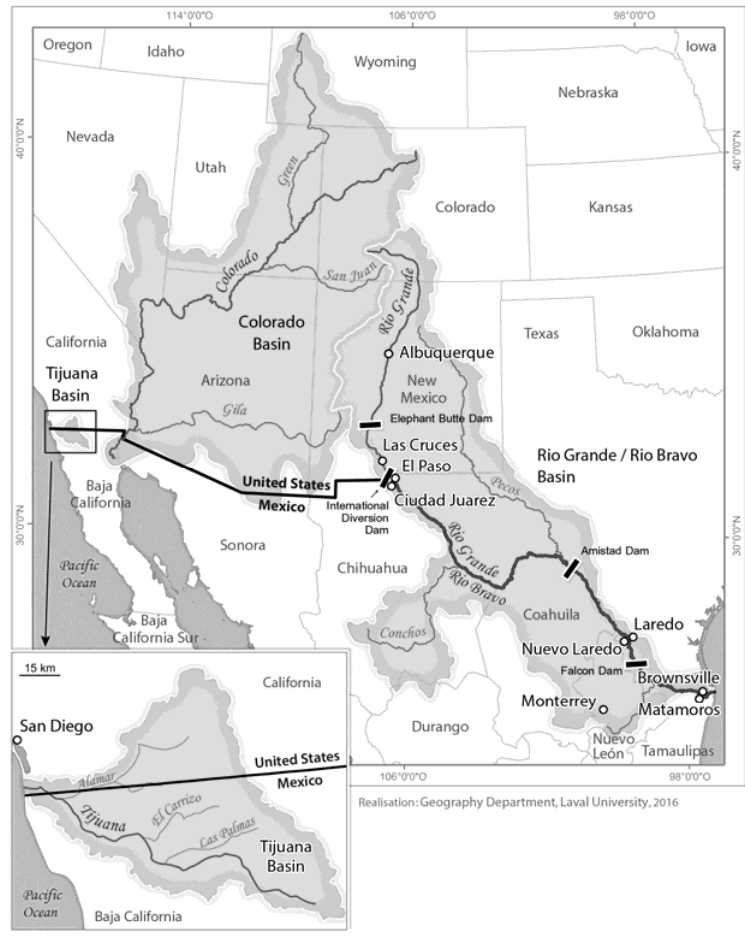
Figure 1. The U.S. and Mexico Transboundary Rivers. Courtesy of the Geography Department, Laval University, 2016.